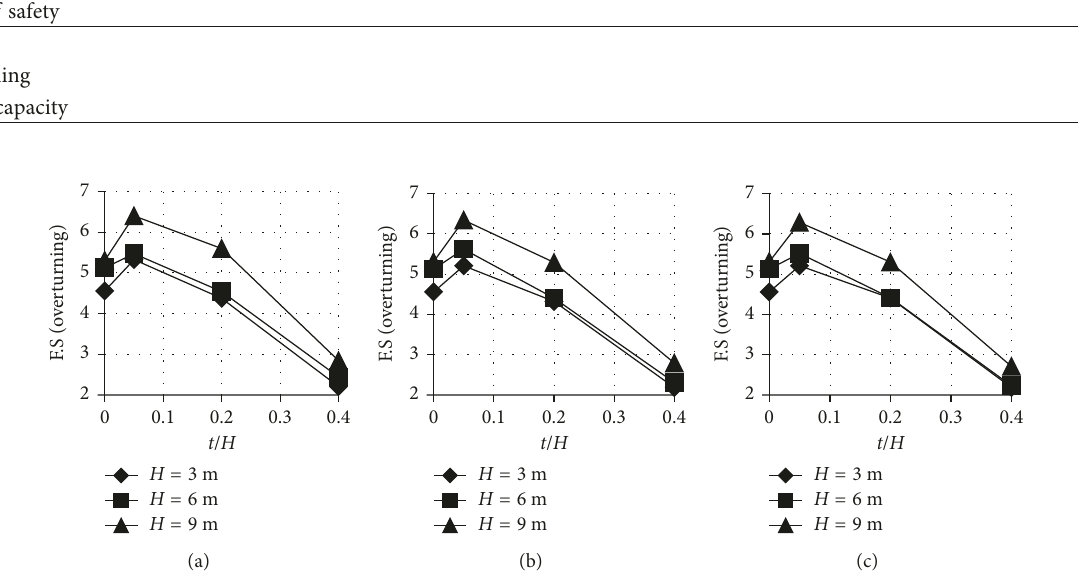
Table 5: Cantilever retaining wall factors of safety.